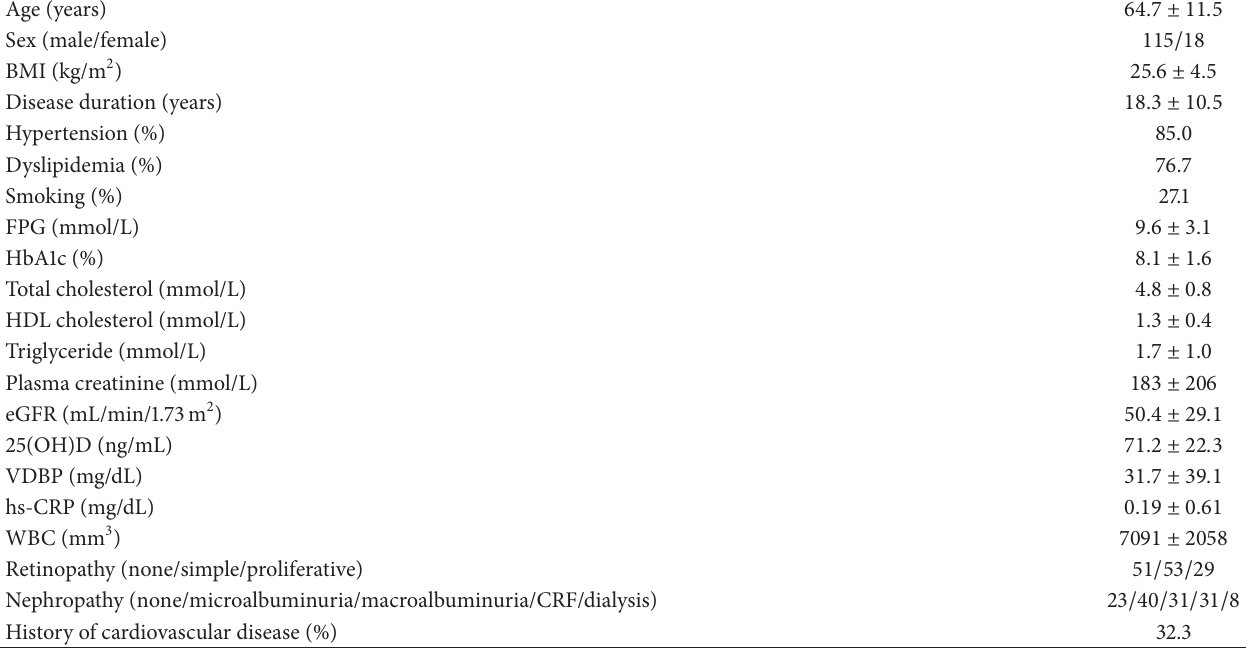
Table 1: Clinical characteristics of study subjects.